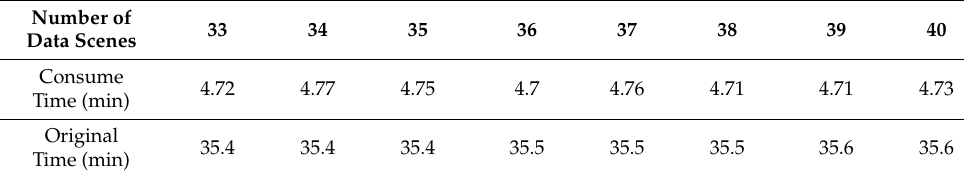
Table 6. Time-consuming statistics